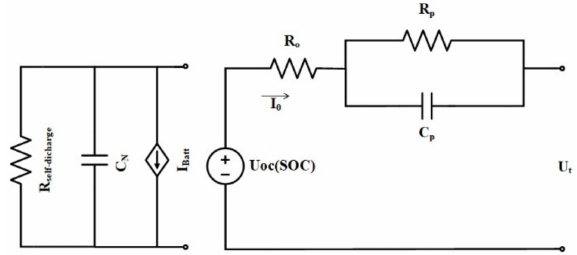
Figure 7. 1-RC model considering self-discharge phenomenon [24].